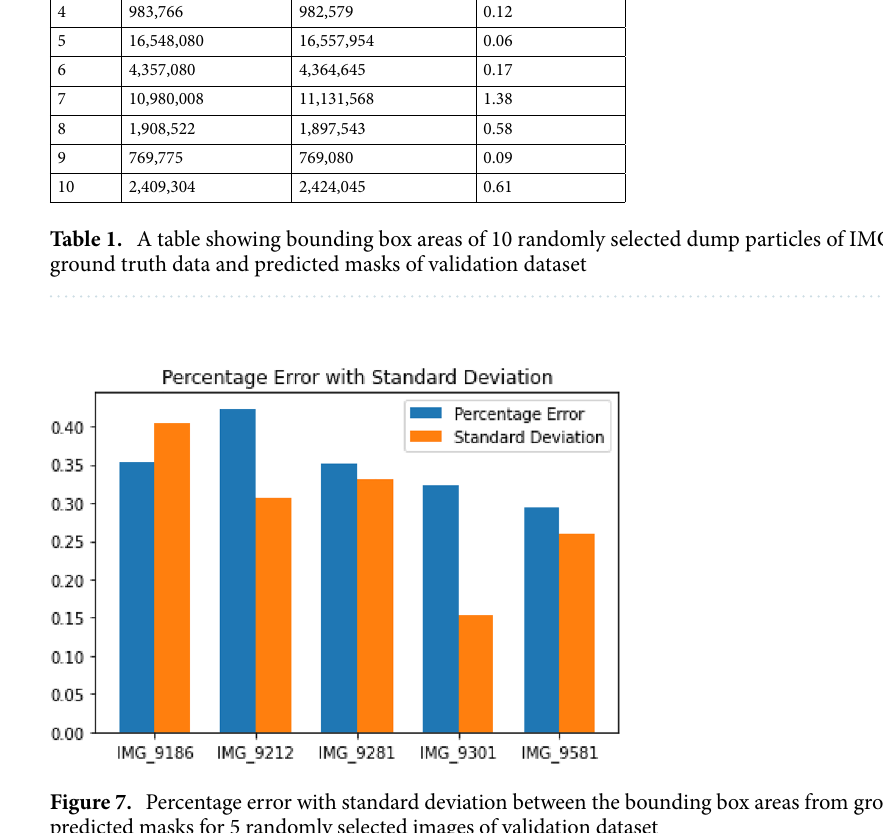
Figure 7. Percentage error with standard deviation between the bounding box areas from ground truth and predicted masks for 5 randomly selected images of validation dataset